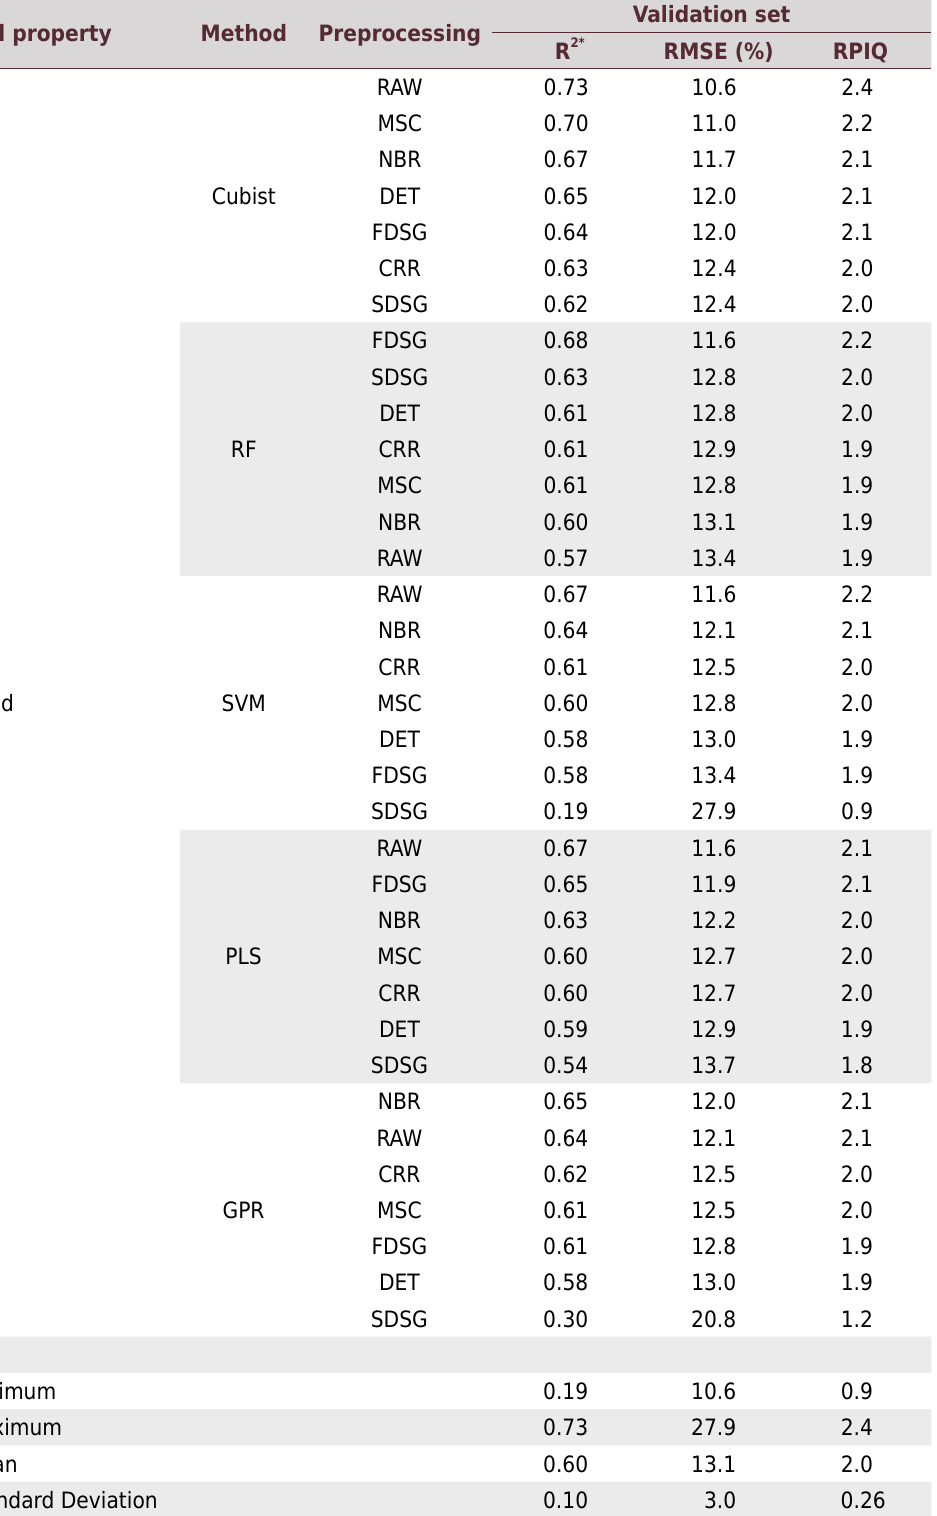
* Sorted by ascending order of R 2 (coefficient of determination for validation